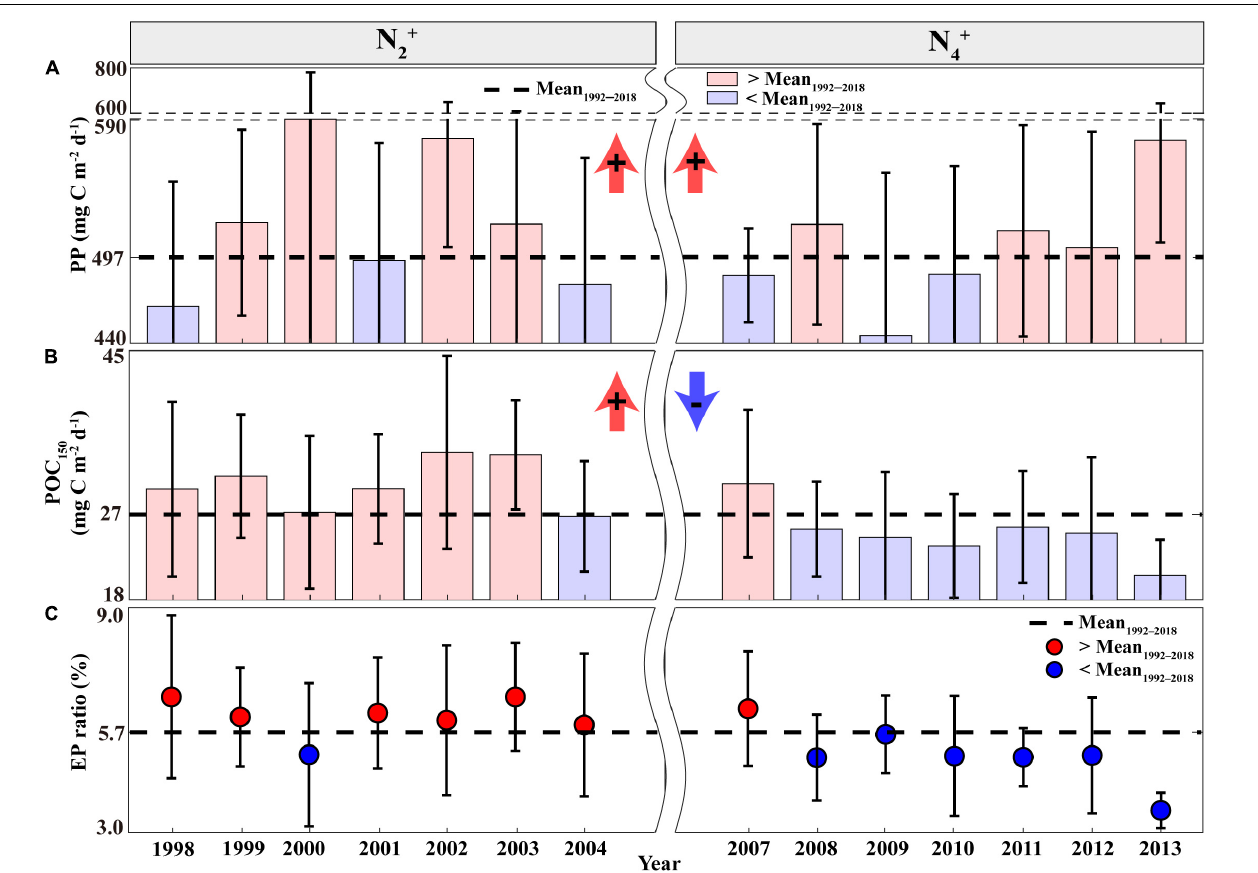
FIGURE 2 | Annual time series of the (A) PP, (B) POC 150 flux, and (C) EP ratio measured at Station ALOHA during the N 2 + and N 4 + phases. Error bars indicate the STDs, the dotted black line indicates the average during the study period, and bars and circles indicate annual averages exceeding (red) and lower (blue) than the study period average, respectively. POC 150 , particulate organic carbon flux; PP, primary production; EP, export